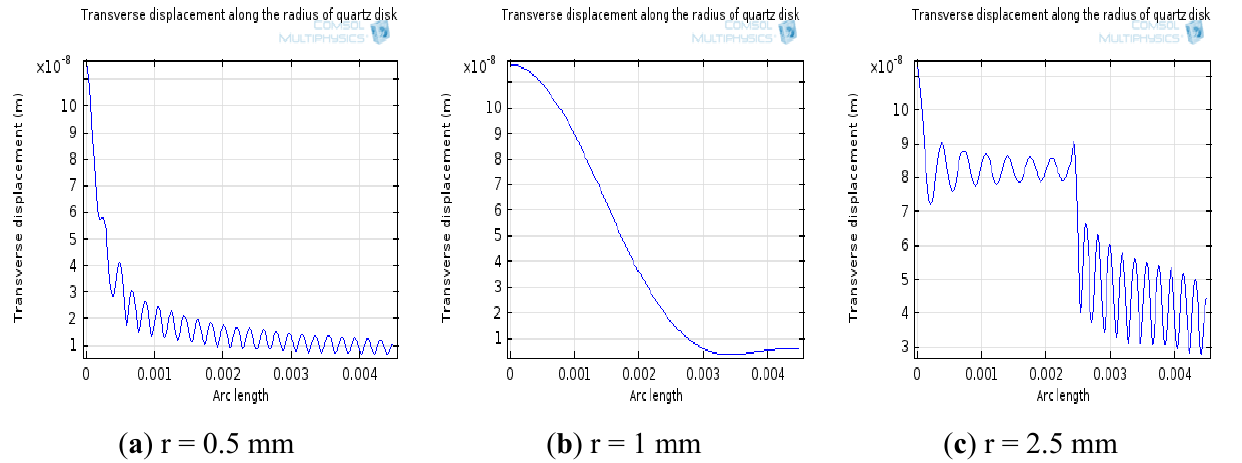
Figure 7. The simulation results of transverse displacements along the radius of AT-cut quartz disk with different sizes of